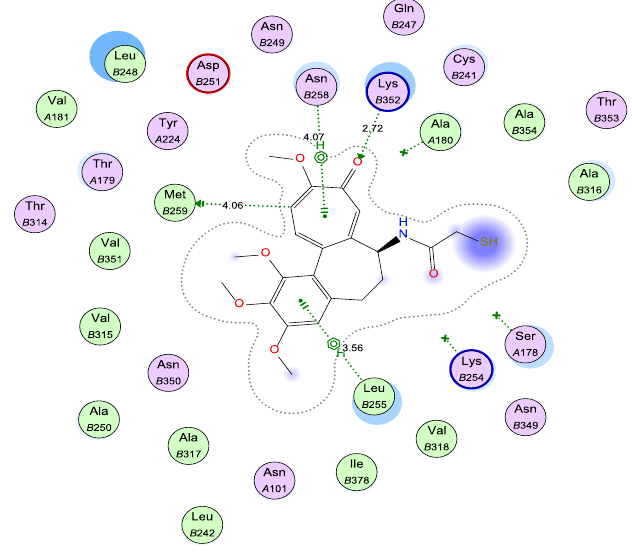
Figure 7. 2D interaction of colchicine with tubulin binding site.